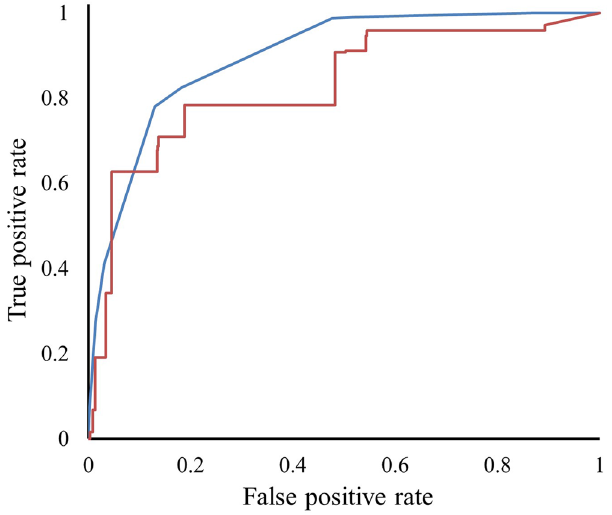
Figure 4. The receiver operating characteristic (ROC) curve plotted for the classification model using training dataset (blue) and leave-one-out cross-validation (red).